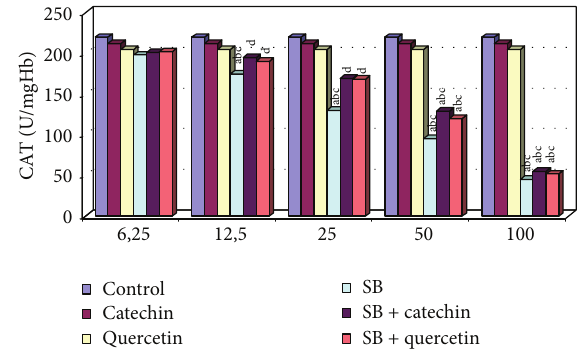
Figure 3: CAT activity in erytrocytes of control and experimental groups. Different letters above the bars indicate significant differ- ences between exposure concentrations; bars with the same letter are not significantly different. Values are mean ± SD in each group. Significance at 𝑃 < 0.05 .